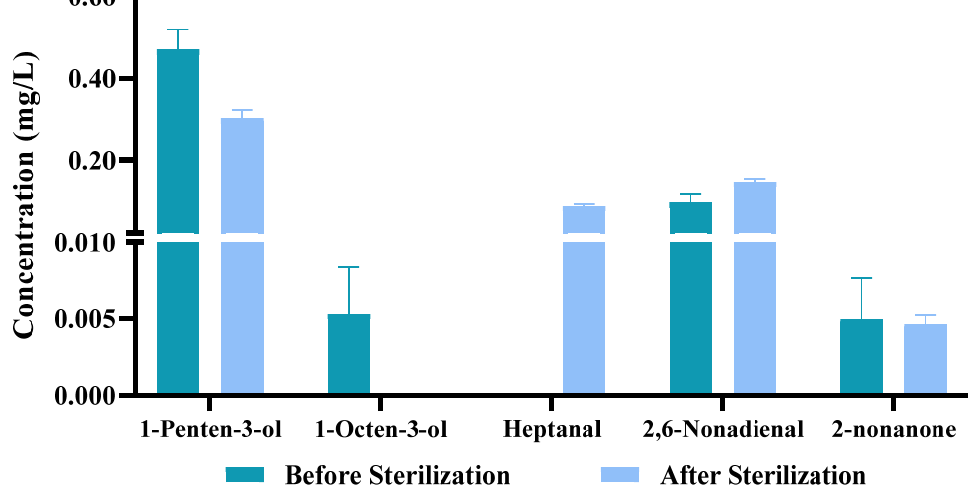
Figure 8. Effect of sterilisation on the concentration of aromas presents in the product obtained with the chitosan/carrageenan combination at higher the chitosan/carrageenan combination at higher concentration.